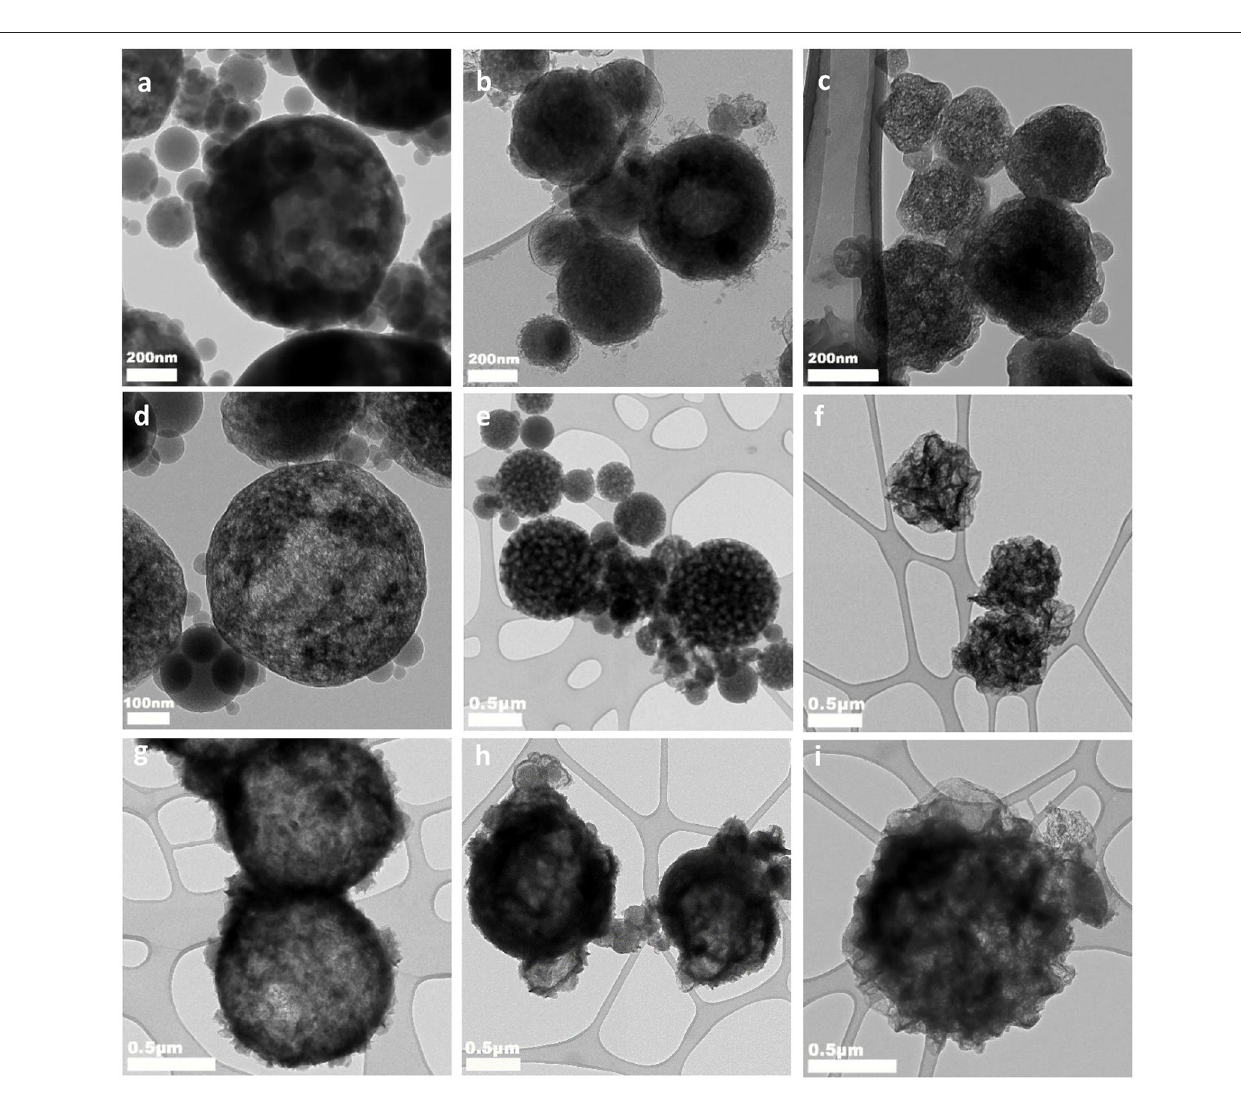
Frontiers in Chemistry | www.frontiersin.org